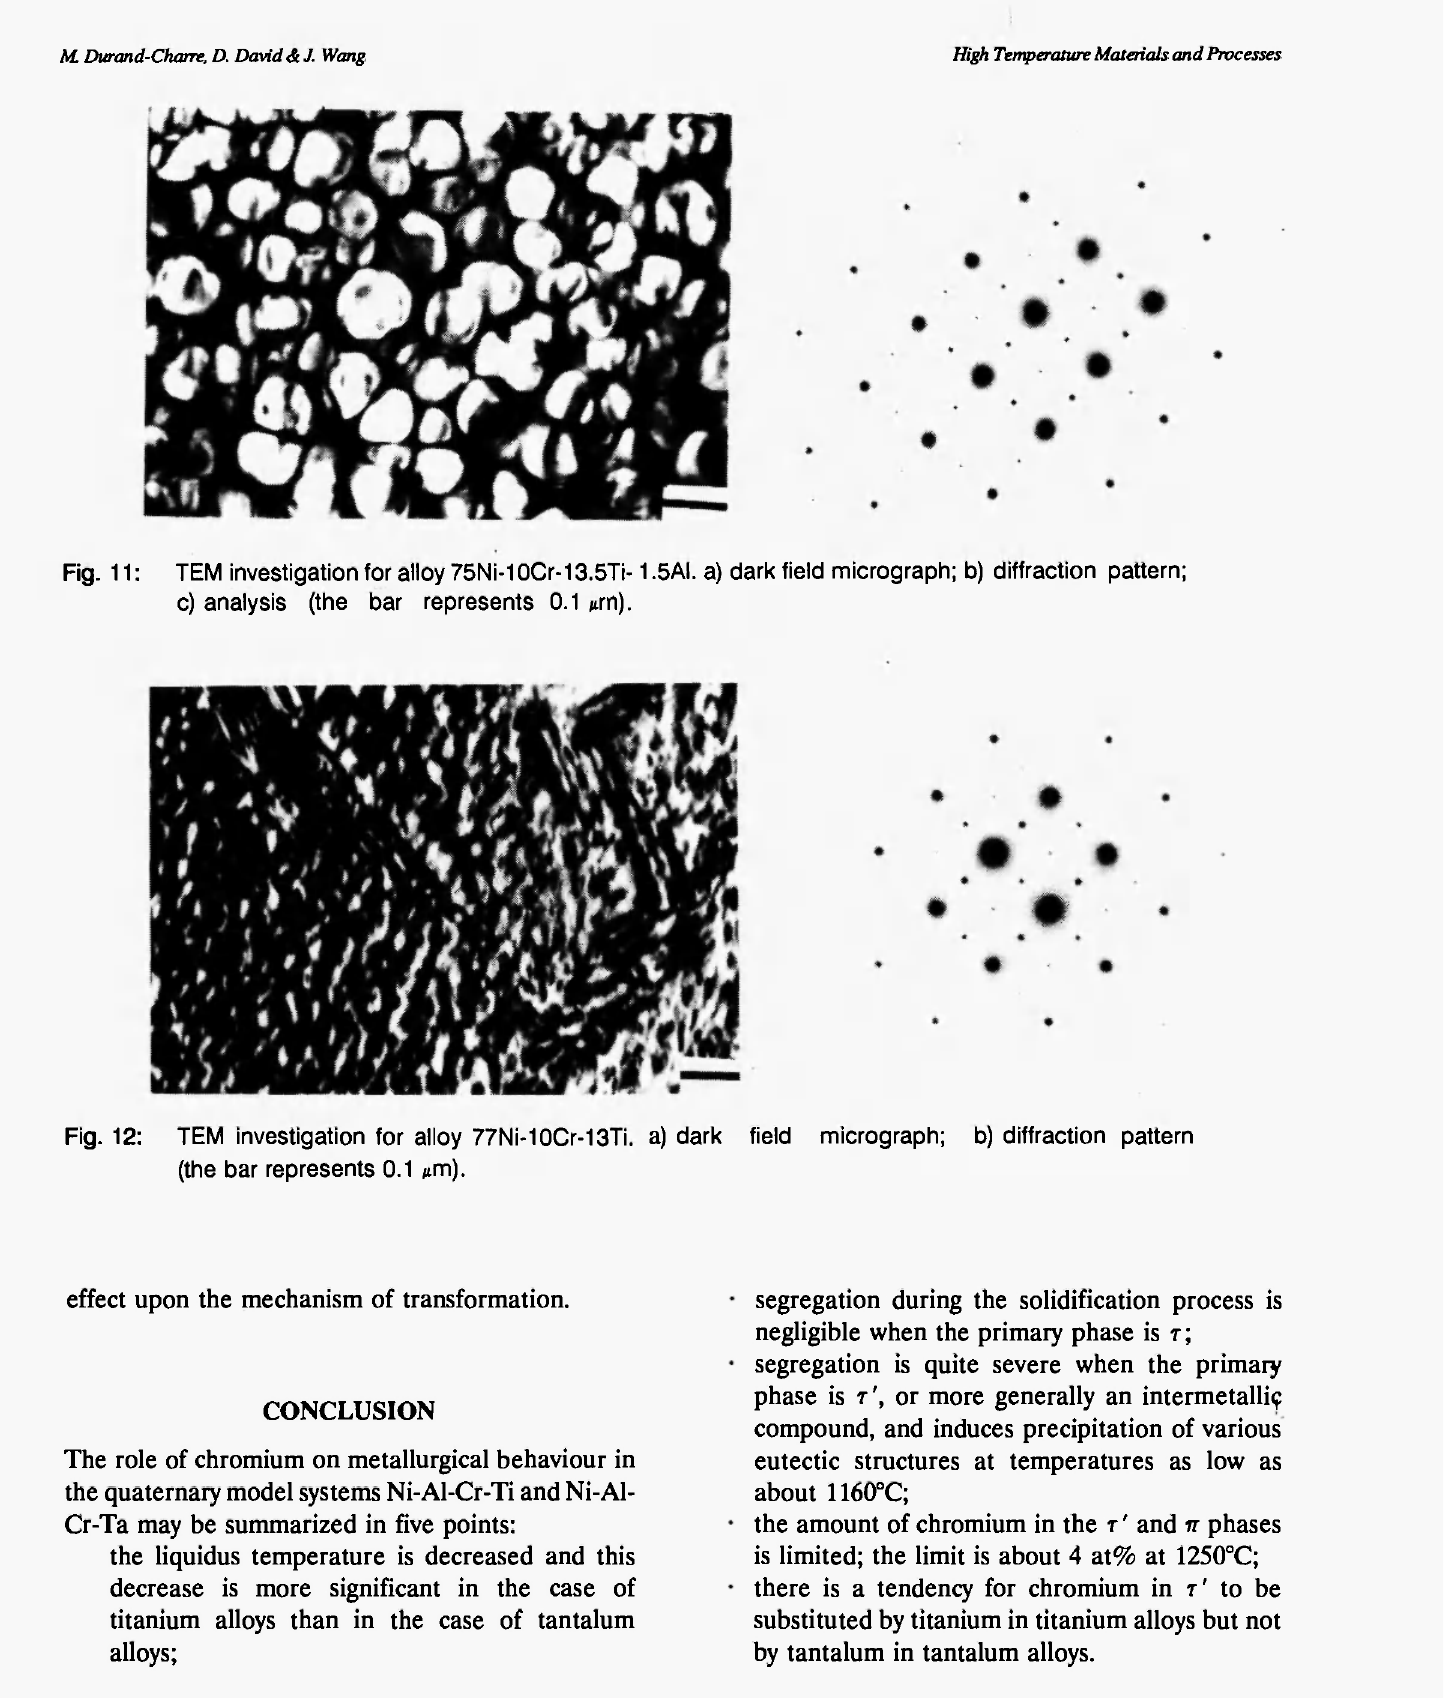
Fig. 12: TEM investigation for alloy 77ΝΪ-10Cr-13Ti. a) dark field micrograph; b) diffraction pattern (the bar represents 0.1